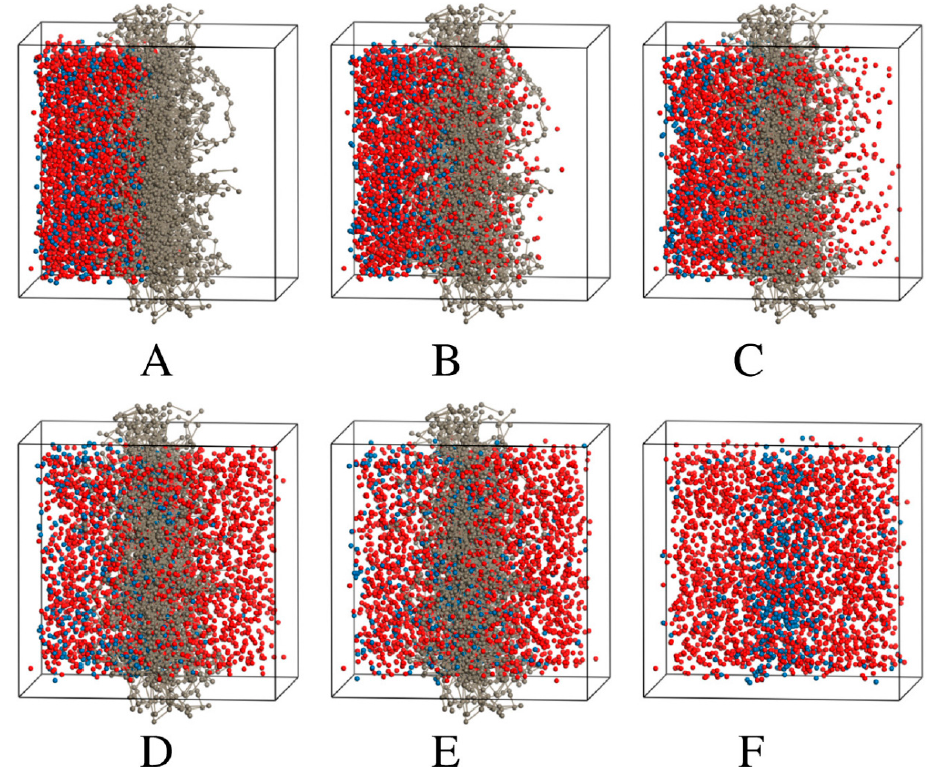
Figure 4. A simulation box of 4:1 charged:neutral drug beads, with wall beads (purple), nitrocellulose (grey), salicylic acid (blue) and salicylate (red). Only nitrocellulose, neutral and charged drug beads are shown at different multiples of τ during the trajectory simulation; ( A ) 1 τ , ( B ) 7500 τ , ( C ) 25,000 τ , ( D ) 125,000 τ , ( E ) 250,000 τ and ( F ) 500,000 τ (nitrocellulose is not shown) (see electronic version for colour figure).